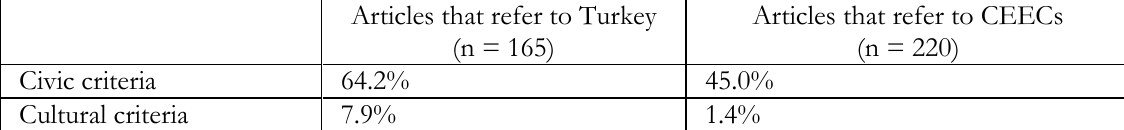
Table 1: Civic and cultural criteria mentioned with reference to Turkey and CEECs Articles that refer to